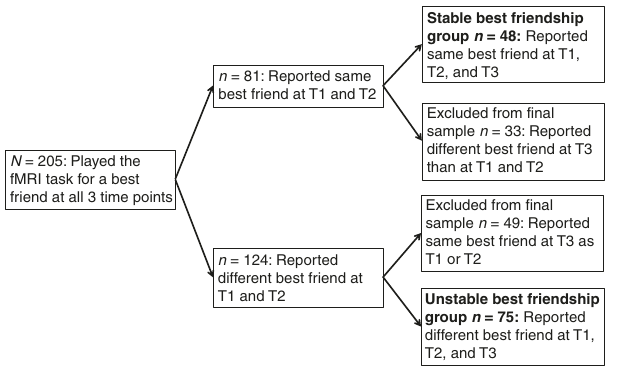
Fig. 3 Flow chart of participant selection. We collected data from 298, 287, and 274 participants at the fi rst, second, and third time point, respectively. Of these participants, 205 played the fMRI task for their best friend at all three time points, of which 48 participants with stable best friendships and 75 as participants with unstable best friendships. T1 = time point 1, T2 = time point 2, T3 = time point 3.